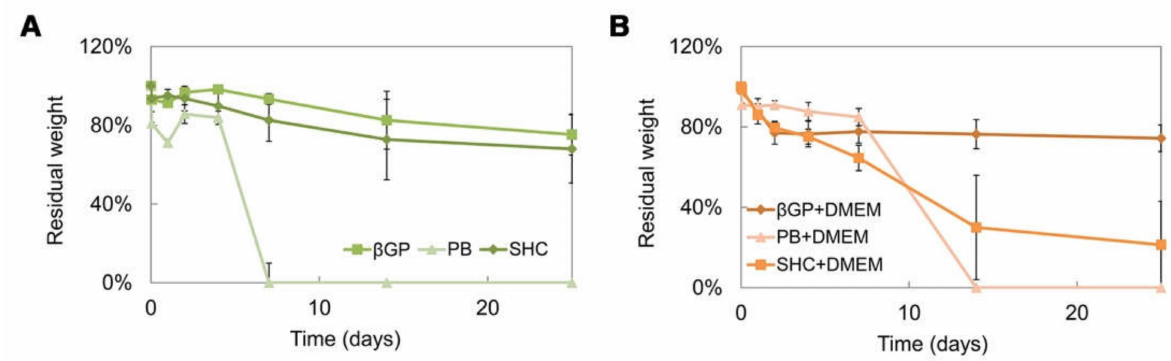
Figure 5. Residual weight percentage after 25 days of incubation in PBS at 37 ◦ C of the three hydrogel formulations ( β GP-PB-SHC) without DMEM ( A ), and with DMEM ( B